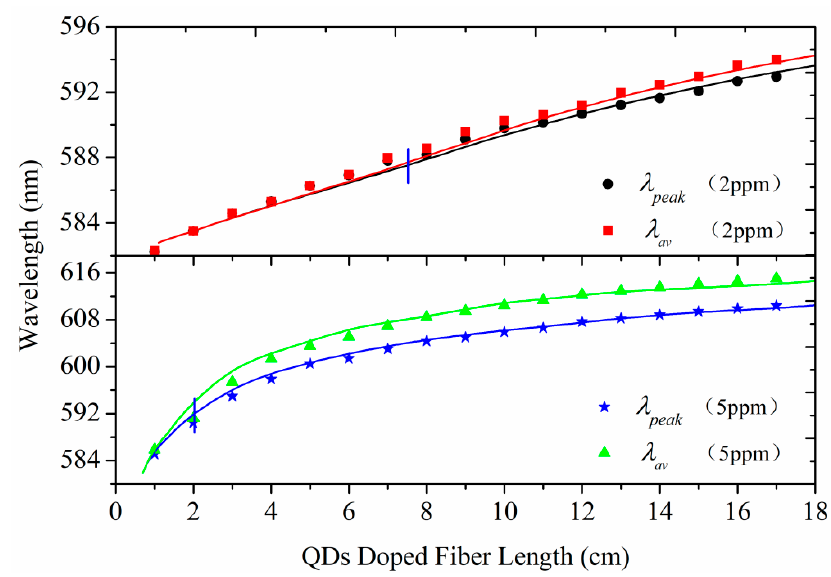
Figure 6. Peak wavelength and average wavelength of two kinds of fiber with doping concentra- tions of 2 ppm and 5 ppm as a function of doped fiber length (the solid lines were the simulation results, and the dots were the experimental results).